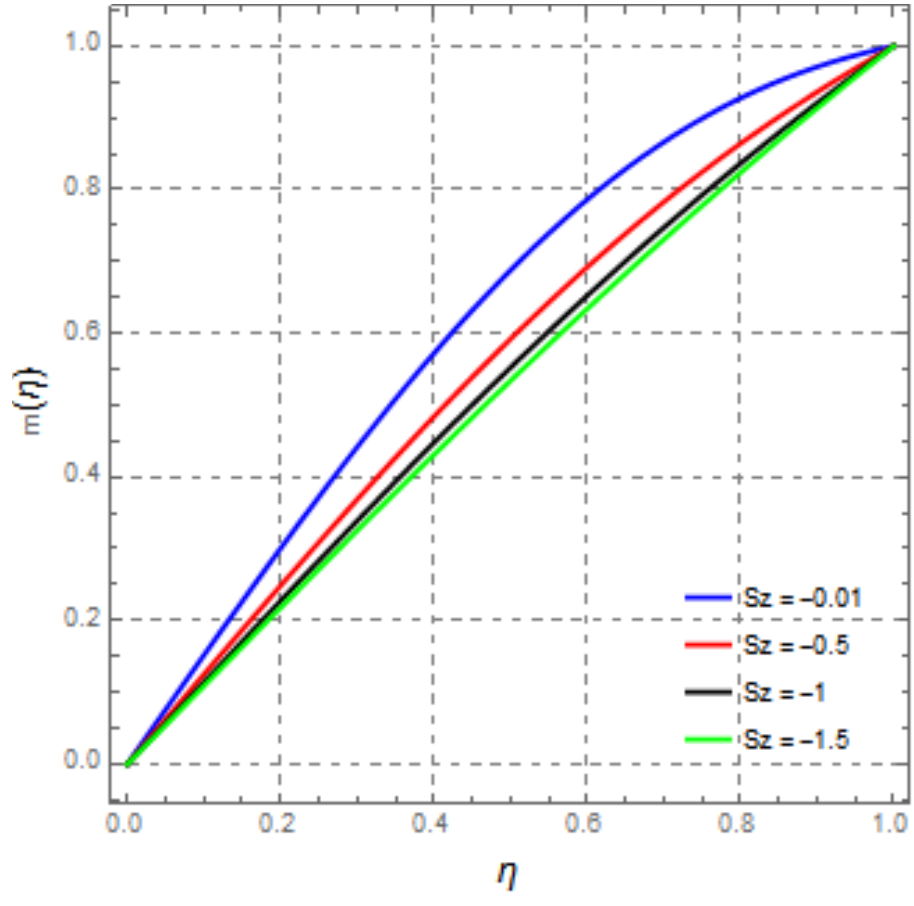
Figure 7. Impact of squeeze Reynolds number S z on the magnetic field component m , keeping M x = − 1.5, M y = 0.5, R m = − 1, and S =